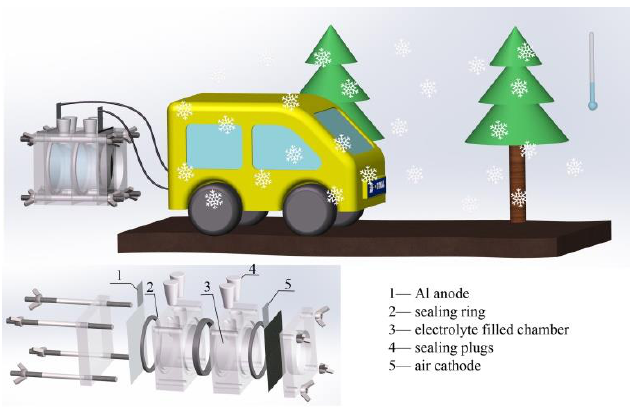
Figure 1. Schematic illustration of the assembled Al – air battery.